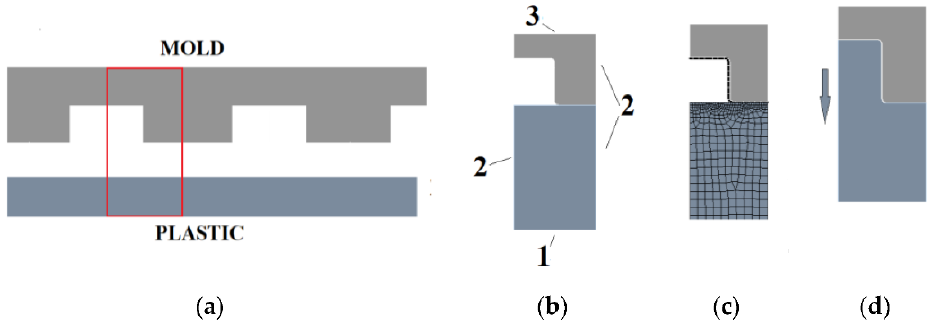
Figure 6. Simplified microstructure. ( a ) Cross-sectional shape of the mold and thermoplastic sub- strate; ( b ) analyzed model: 1 — fixed support, 2 — frictionless support and 3 — remote displacement; ( c ) meshing of the model; ( d ) deformed analyzed model.